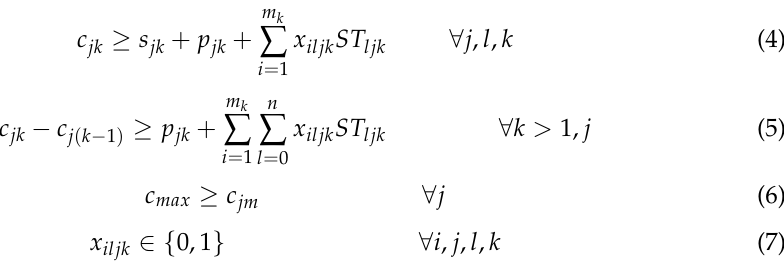
Table 1. Setup times for the RFFSP shown in Figure 1.